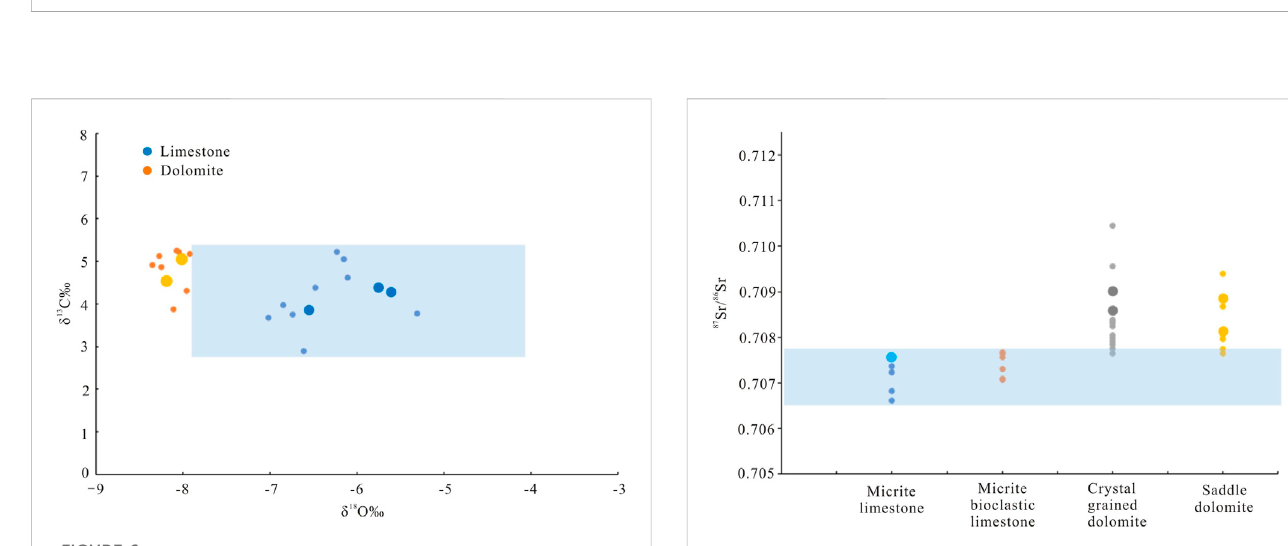
FIGURE 6 Carbon and oxygen isotope characteristics of limestones and dolomites of Permian Qixia Formation in Central Sichuan Basin (partial data from Chen et al., 2012). The blue area represents the range of carbon and oxygen isotopes in early Permian seawater; the enlarged symbol data comes from Chen et al., 2012.